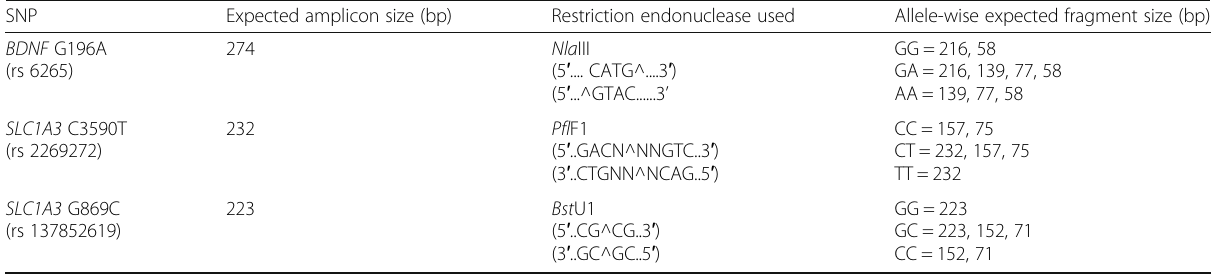
Table 2 Amplicon size, restriction endonucleases used and allele wise expected size of fragments after restriction digestion for the three SNPs